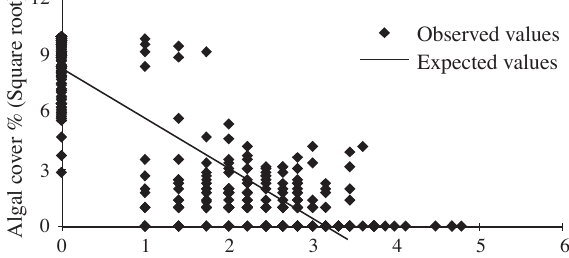
D. antillarum / m 2 (cid:31)(Square (cid:31)root)(cid:31) F IG . 2. – Linear regression between the density of Diadema antil- larum and algal cover. Percent algal cover (square-root trans- formed) = 8.26 – 2.60 Diadema antillarum /m 2 (square-root trans formed); R 2 = 75.6%; n =